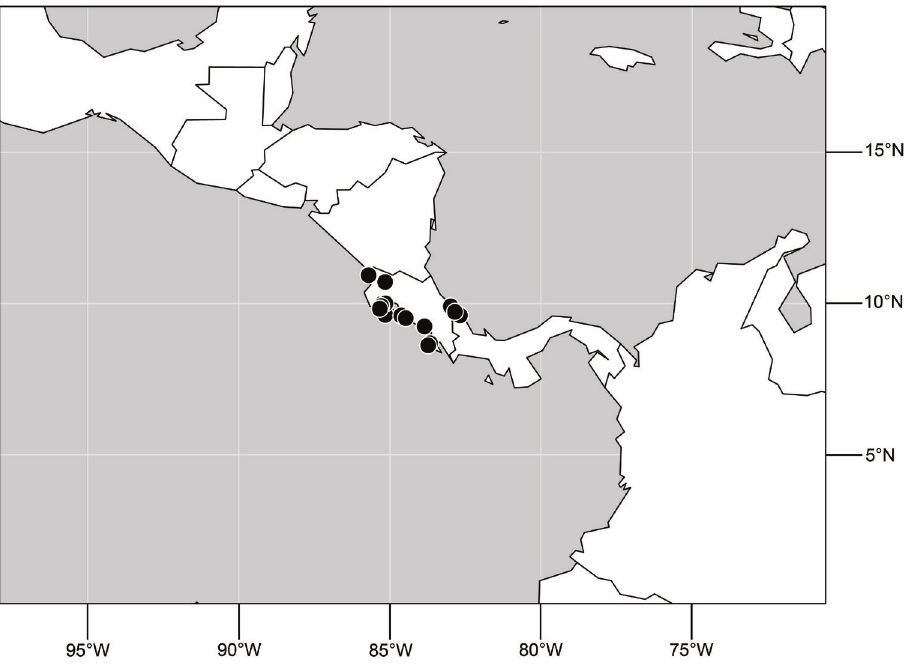
Figure 48. Distribution of Hydrochasma spinosum sp.